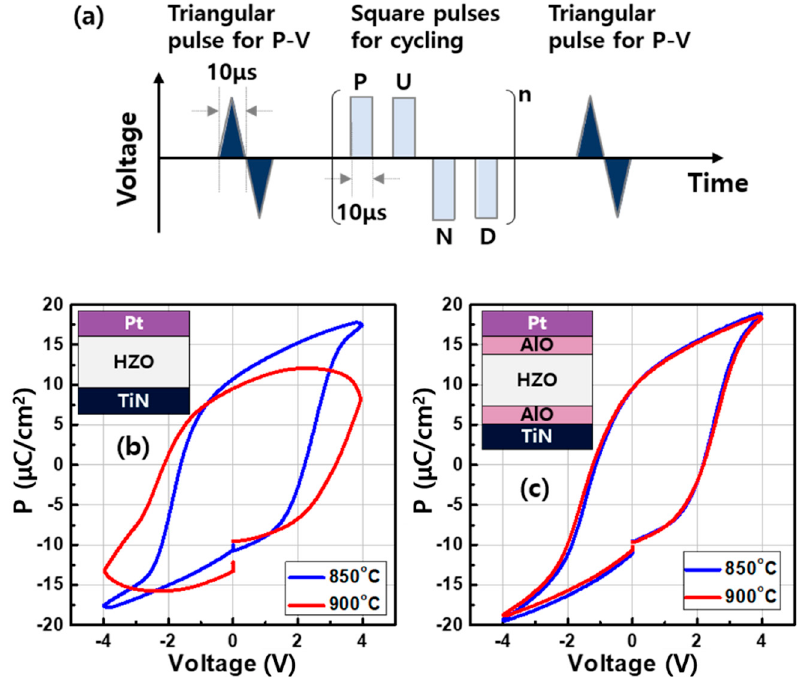
Figure 3. ( a ) The schematic illustration of each pulse for the P–V test and PUND cycling. The P–V curves after 10 3 PUND cycles of the ( b ) single layer HZO and ( c ) trilayer AlO / HZO / AlO. The devices were annealed via RTA at temperatures of 850 and 900 °C.